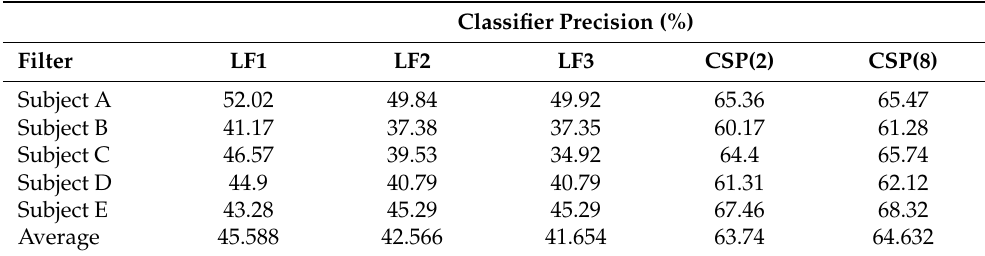
Table 7. Spatial filter comparison.